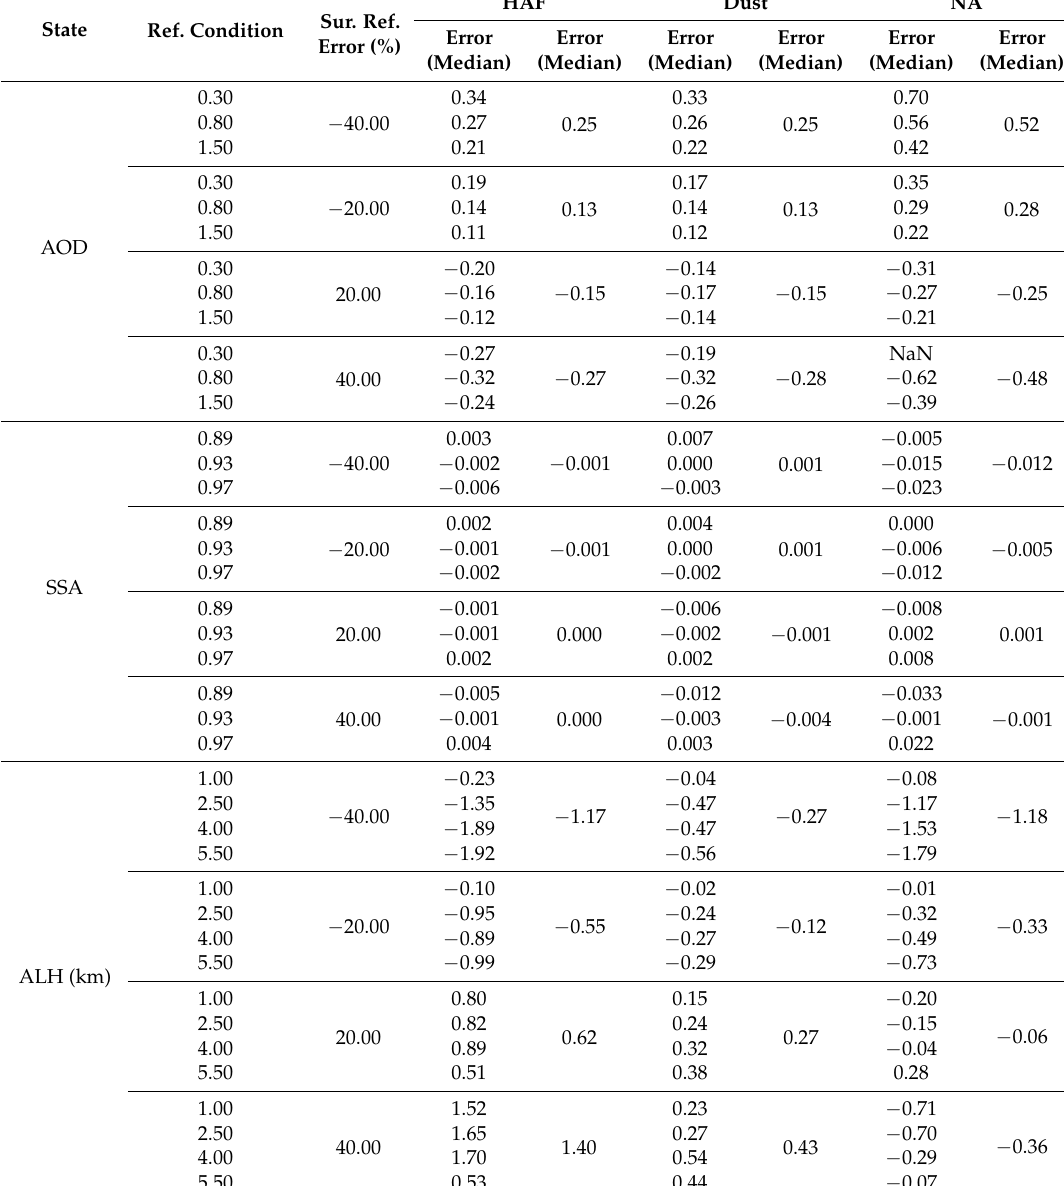
Table 5. Median values of the data plotted in Figure 12. Errors are the median retrieval error obtained by comparing retrieved values from the developed algorithm with the reference condition, assuming biased